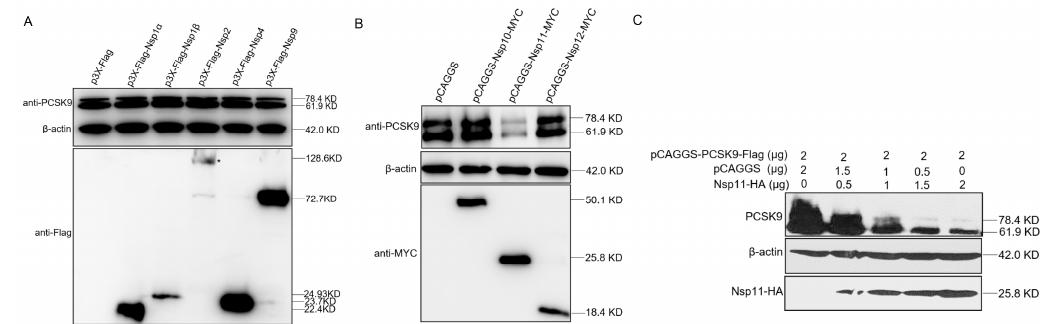
Figure 6. PRRSV nsp11 could inhibit PCSK9 expression. ( A and B ) PRRSV non-structural protein